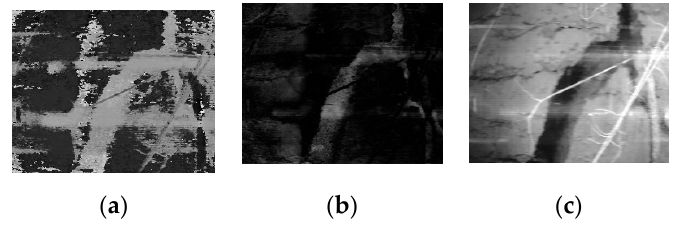
Figure 8. Division of image in HSV plane: ( a ) H Plane, ( b ) S Plane, and ( c ) V Plane.